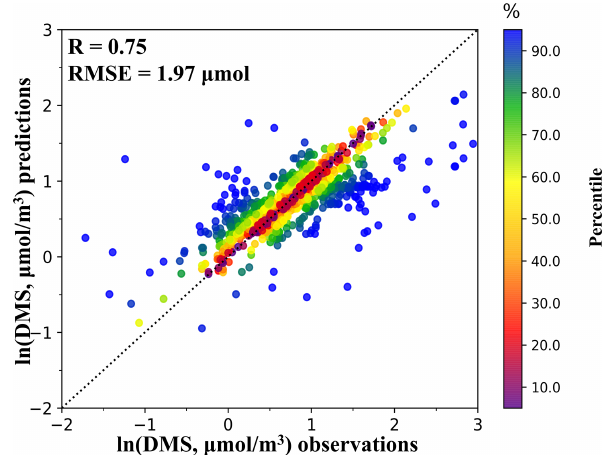
Figure 1. The scatter plot compares model predictions and obser- vations of DMS. The color represents the percentile of distribution of absolute difference between predicted and observation